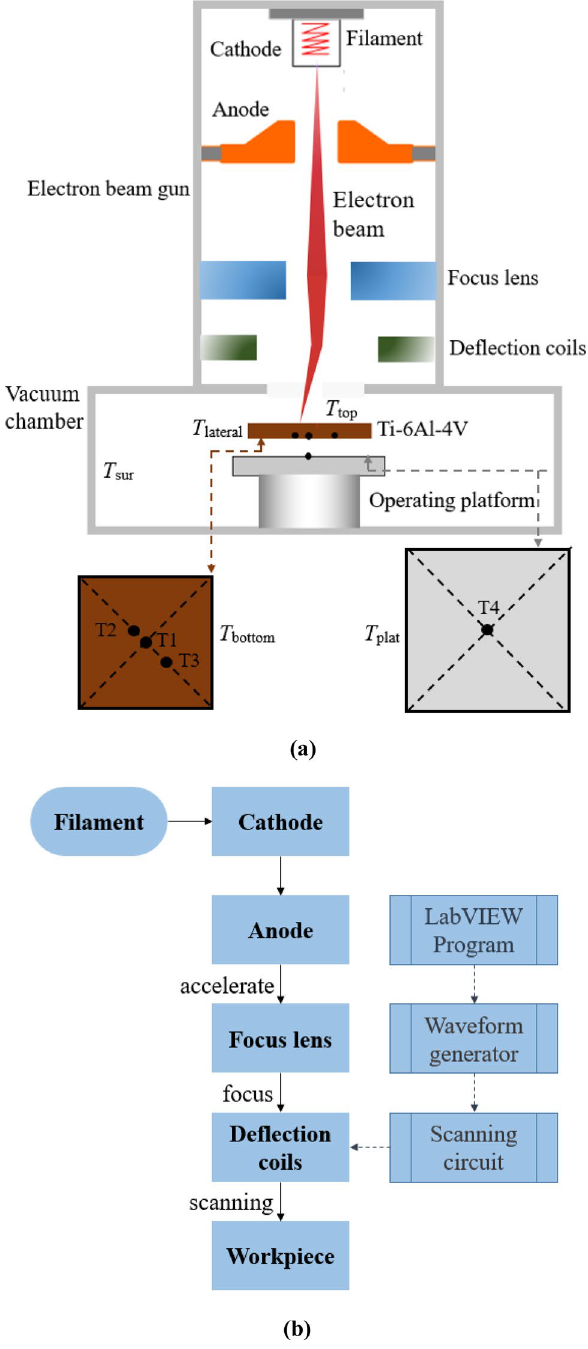
Figure 2. Schematic of the experimental equipment and the beam controlling scheme. ( a ) Schematic of the electron beam thermal assessment equipment. ( b ) Schematic of the controlling scheme and formation process of an electron